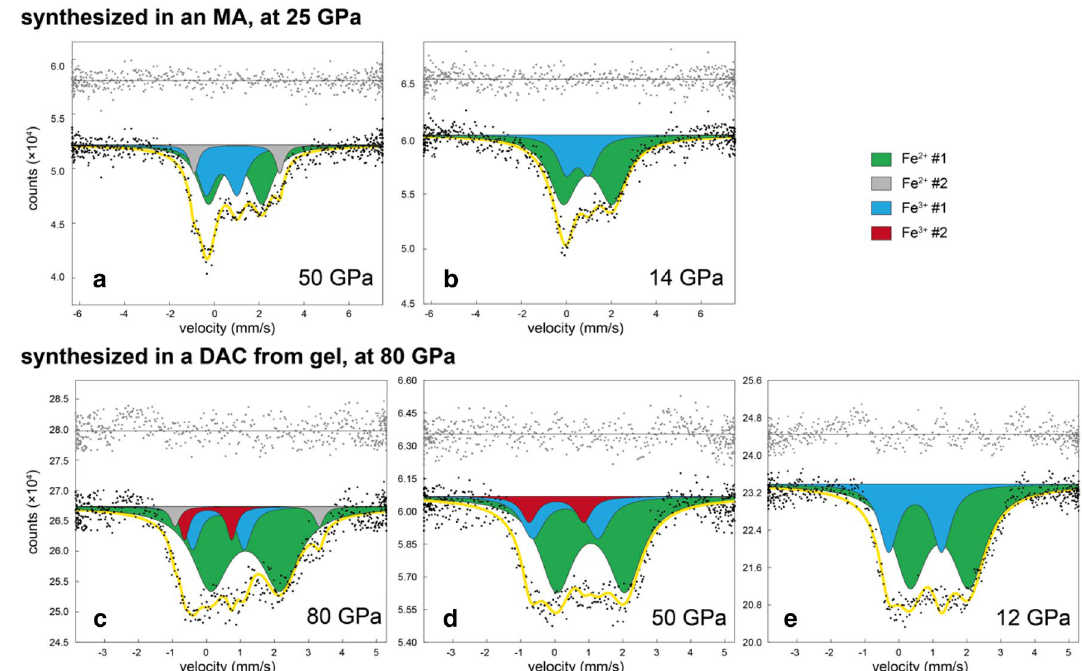
Figure 2. Evolution of the obtained SMS spectra of bridgmanite samples with decreasing pressure. ( a , b ) Bridgmanite synthesized in an MA at 25 GPa and 1673 K (MAOS3265) at 50 and 14 GPa, respectively, and ( c – e ) bridgmanite synthesized in a DAC at 80 GPa and 2500 K (DACMSRd01) at 80, 50, and 12 GPa, respectively. Green, grey, light blue, and red doublets indicate the components Fe 2+ #1, Fe 2+ #2, Fe 3+ #1, and Fe 3+ #2, respectively. Yellow curves show the theoretical fit, and grey symbols indicate the